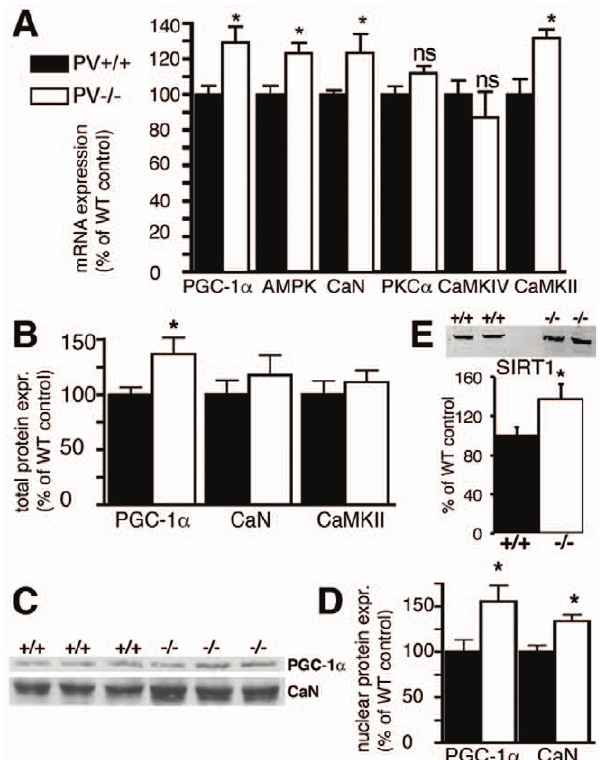
Figure 7. Expression levels of molecules implicated in excita- tion/transcription coupling and mitochondria biogenesis in mouse skeletal muscle. A) Differences in mRNA levels in tibialis anterior (TA) from adult PV + / + and PV 2 / 2 mice determined by RT-PCR. Significant increases were observed for PGC-1 a , AMPK, CaN and CaMKII (*; p , 0.05). Semi-quantitative Western blot analyses with whole muscle TA protein extracts (B) and TA nuclear extracts from PV + / + and PV 2 / 2 mice (D). Significant increases in PV 2 / 2 nuclear PGC-1 a and CaN were detected compared to PV + / + mice (*p , 0.05). C) Representative Western blots for PGC-1 a and CaN from three PV + / + and PV 2 / 2 mice. Note the stronger signals in extracts from PV 2 / 2 mice. E) SIRT1 expression levels in TA from adult mice were increased in PV 2 / 2 mice; representative SIRT1 Western blot signals from 2 mice of each genotype (upper